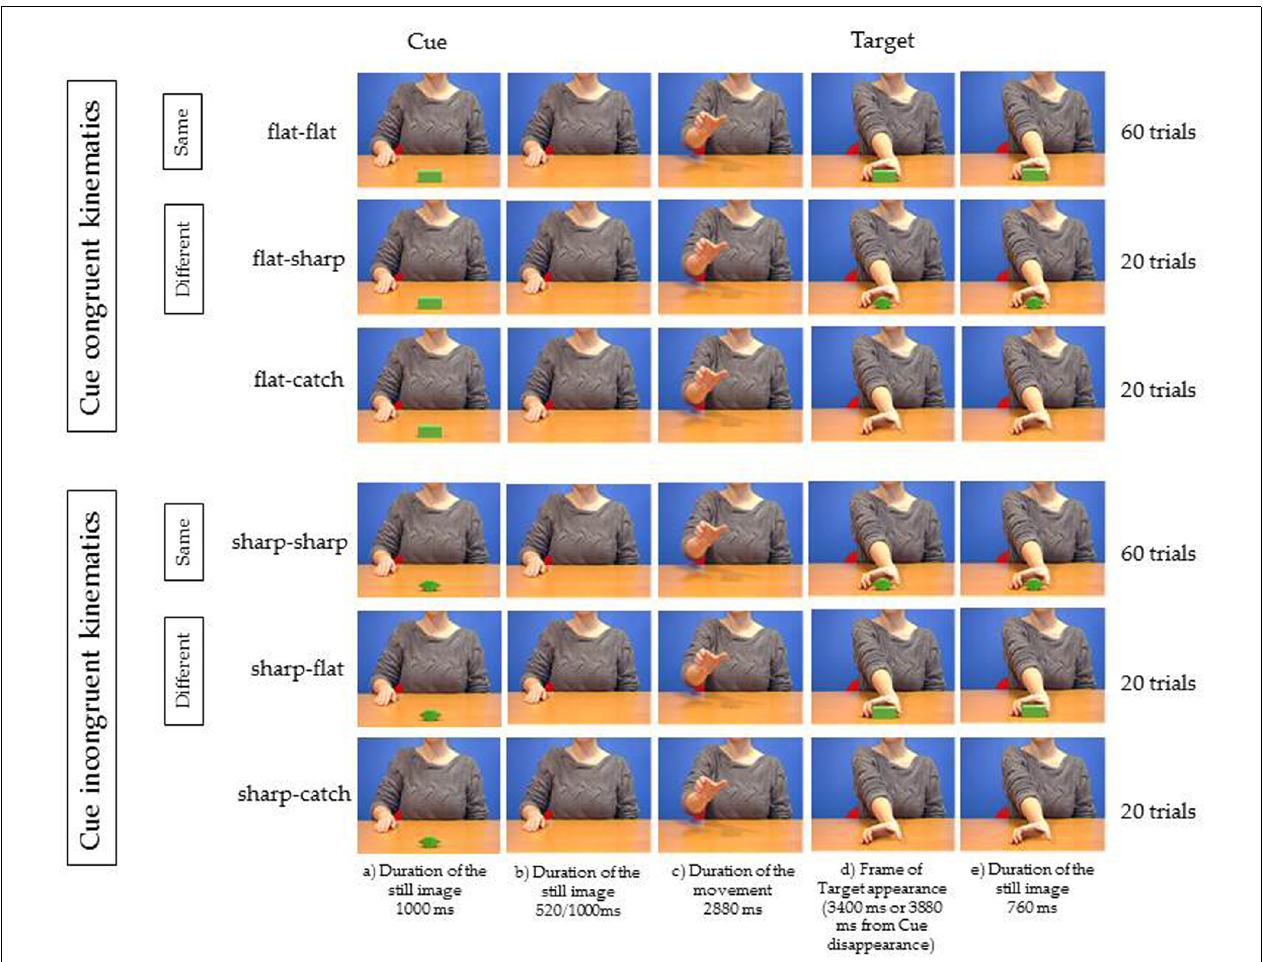
FIGURE 1 | Experiment 1. Five frames relative to each of the six videos used as stimuli. The object shown at step (a) for 1000 ms is the Cue and represents the Target appearing in 60% of the trials (Same trials). In 20% of the trials the uncued Target was presented (Different trials). In 20% of the trials the Target was not presented. Participants had to respond by tapping with their right index finger on a conducting pad placed on the table when Target object appeared (flat–flat, flat–sharp, sharp–sharp, sharp–flat), and to refrain to tap when the object did not reappear (flat-catch, sharp-catch). In one session the kinematics of the agent was suitable to grasp the cued object (Cue congruent kinematics). In the other session the kinematics of the agent was not suitable to grasp the cued object (Cue incongruent kinematics). See text for more